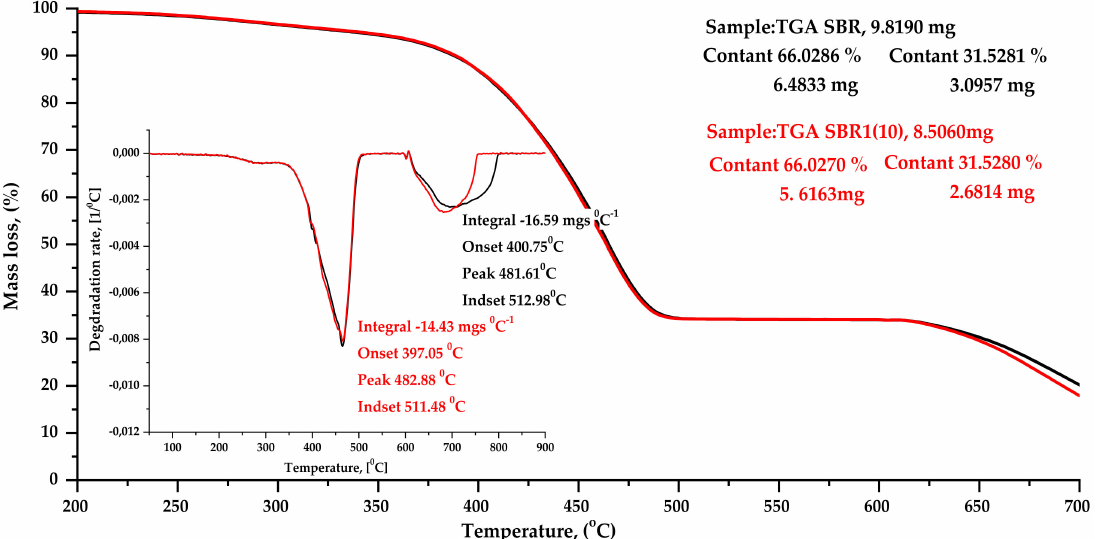
Figure 7. Thermogravimetric analysis (TGA) curves of SBR composites: reference sample SBR (black curve), SBR1 (10) sample (red